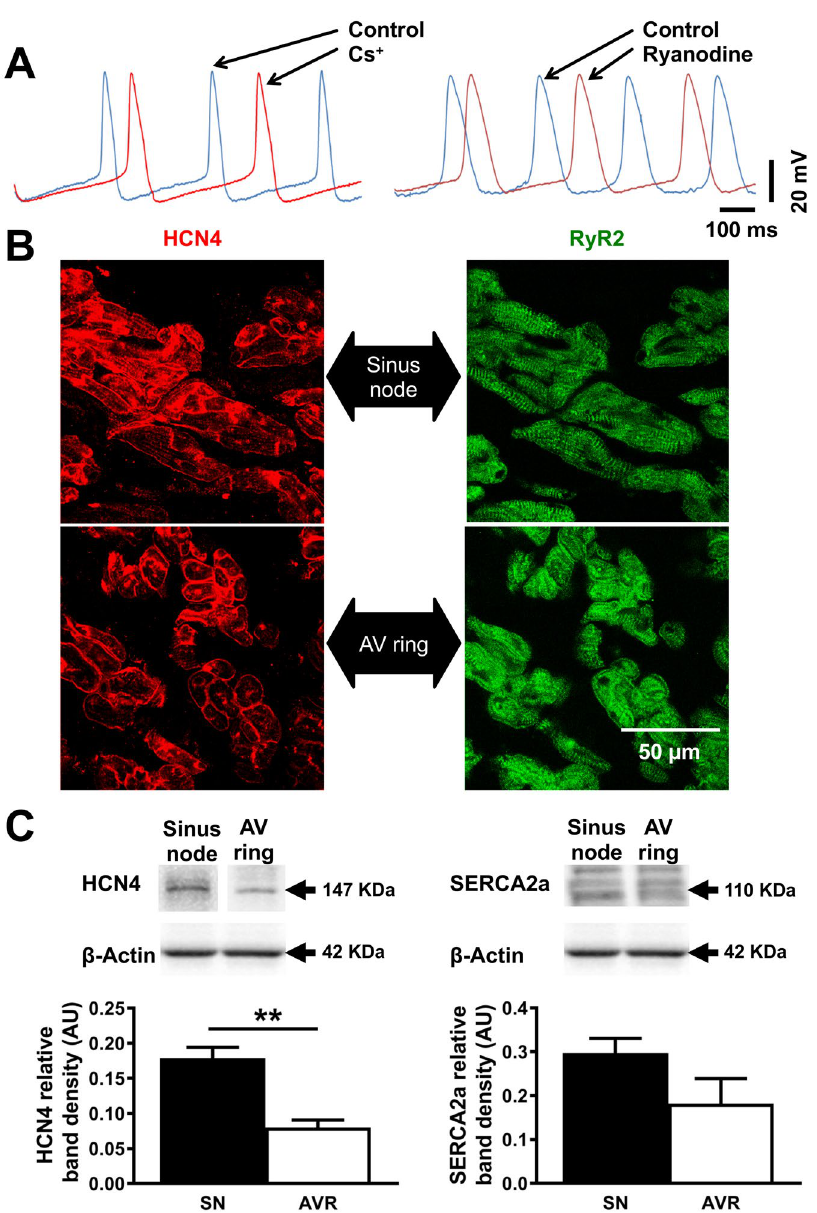
Figure 4. Pacemaker mechanisms in the atrioventricular ring. ( A ) The effects of Cs + and ryanodine on atrioventricular (AV) ring pacemaker action potentials. AV ring pacemaker action potentials at baseline (blue traces), in 2 mM Cs + (left; red trace) and 2 µ M ryanodine (right; red trace). Vertical and horizontal scale bars represent voltage (mV) and time (ms), respectively. ( B ) Sinus node and AV ring tissue sections immunolabelled for HCN4 (red signal) and ryanodine receptor (RyR2, green signal). ( C ) Western blots of HCN4 and SERCA2a in sinus node (SN) and AV ring (AVR). Blots cropped from different parts of the same gel, or from different gels are clearly delineated with white space. Student’s t-test was used for statistical comparison. ** P ≤ 0.01 and n = 4/5